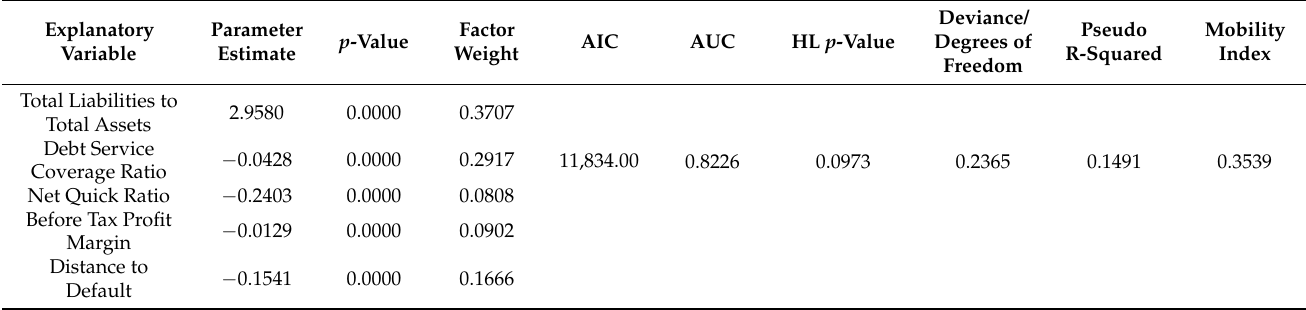
Table 11. Logistic Regression Estimation Results—Moody’s Large Corporate Financial, Macroeconomic and